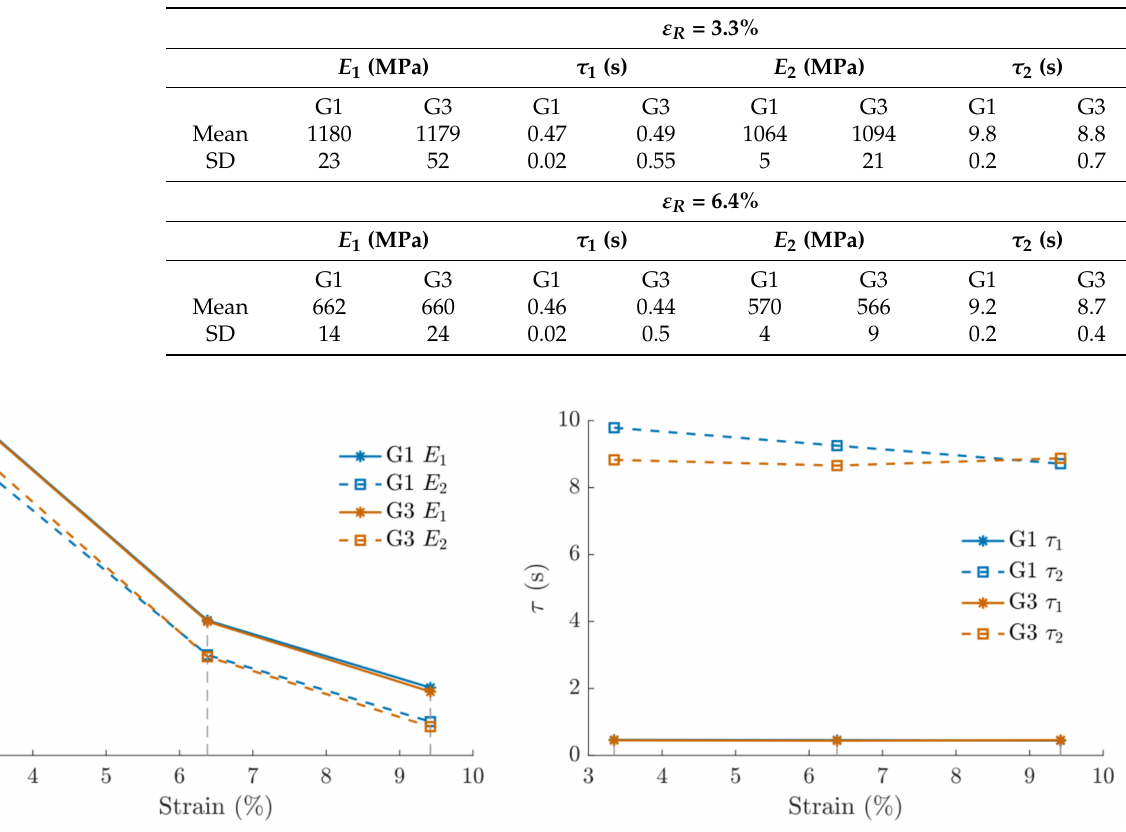
Figure 8. For groups 1 and 3 ( Left ) Strain–relaxation modulus. ( Right ): Strain–relaxation